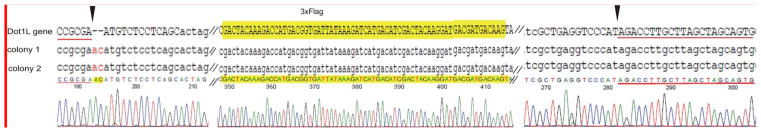
Sequencing results from successfully KI cell. Left panel shows the junction of right flank of endogenous and left flank of plasmid and “ac” were added to guarantee fusion gene in frame. Red underline represents the sequence of Dot1L-P1R. Middle panel shows the sequence of 3 × Flag knocked in. Right panel shows the junction of left flank of endogenous and right flank of plasmid. Redunderlin represents the sequence of Dot1L-P2F.